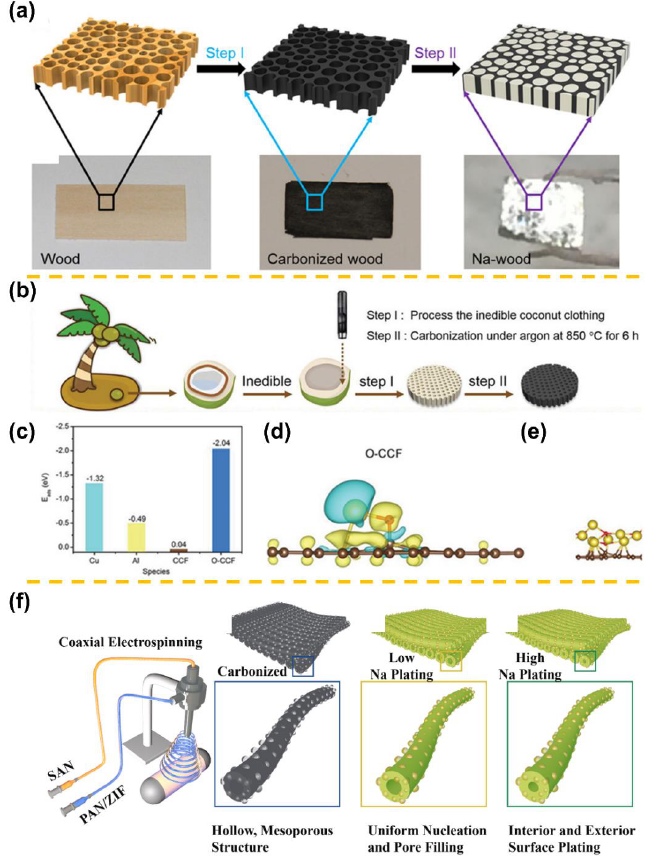
Figure 7. Fabrication process of ( a ) the Na carbonized composite (adapted with permission from ACS) and ( b ) the 3D O-CCF matrix from biomass waste coconut clothing. ( c ) The adsorption energies of Na with Cu, Al, CCF, and O-CCF. ( d ) Differences in charge density of lone Na atoms absorbed on O-CCF. ( e ) The final structures for Na atom adsorption on O-CCF after molecular dynamics simulation (adapted with permission from Wiley). ( f ) Schematic illustration of the coaxial electrospinning setup used for the manufacture of HpCNFs hosts (adapted with permission from Elsevier).